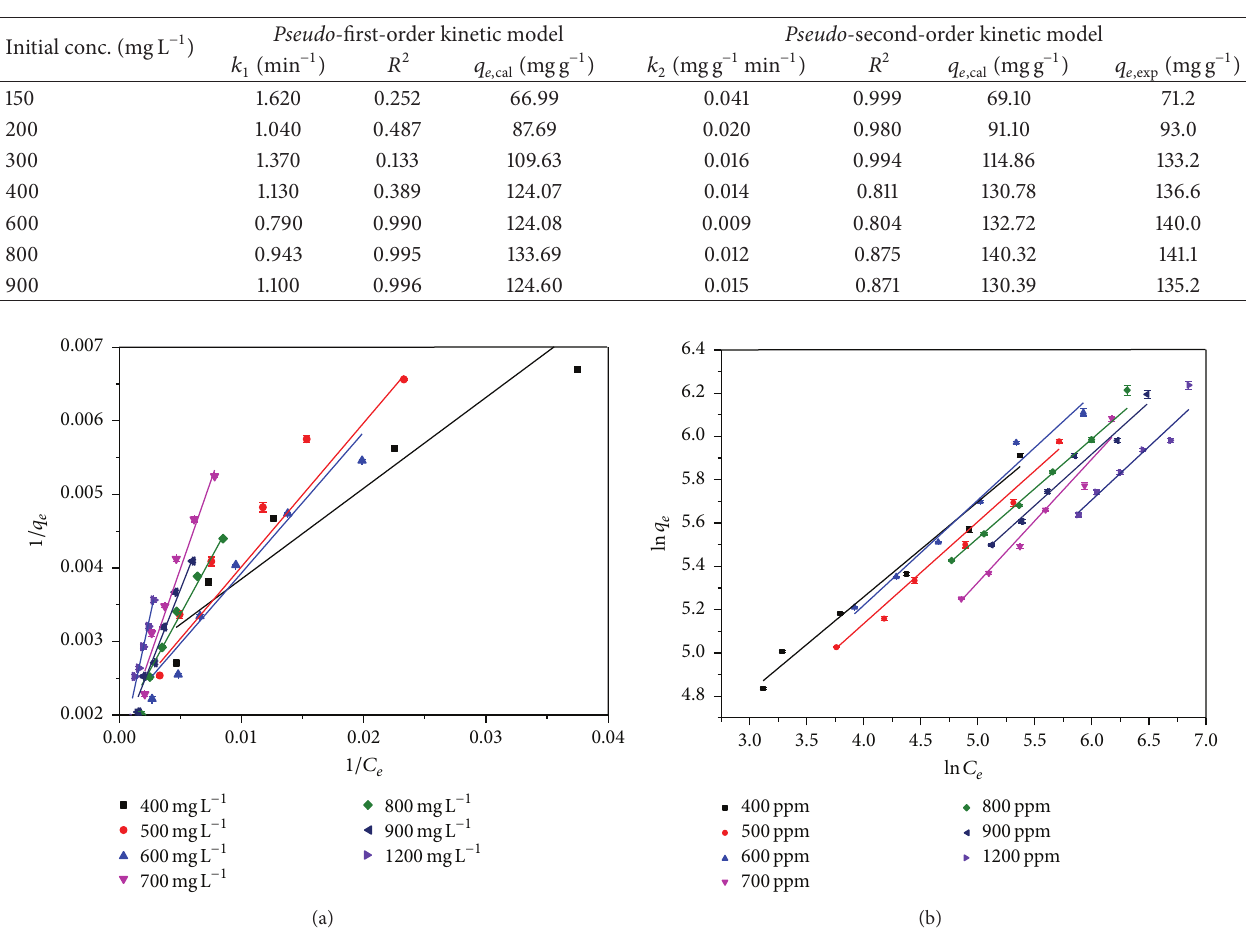
Table 6: Kinetic parameters of pseudo -first- and second-order kinetic model. Initial conc. (mgL −1 )